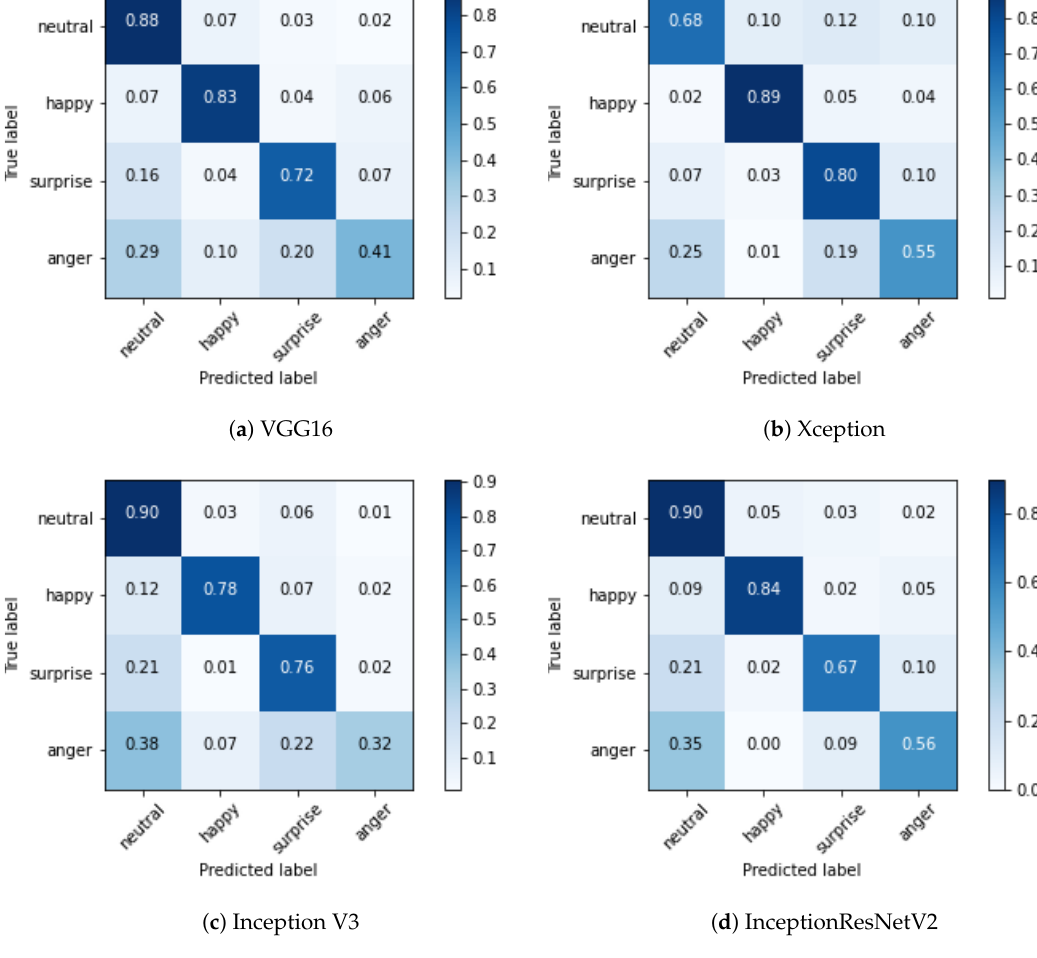
Figure 8. Confusion matrices of the trained networks, with normalised